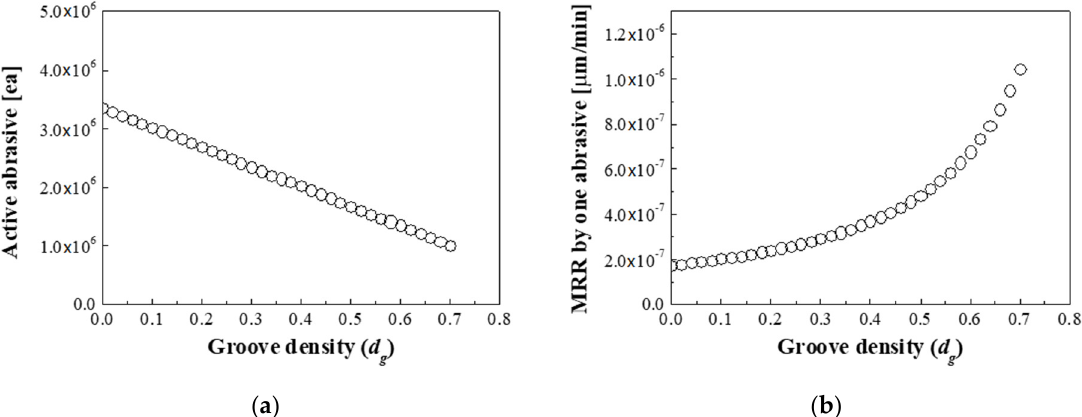
Figure 4. ( a ) Theoretical analysis result of number of active abrasives; ( b ) theoretical analysis result of material removal rate by one abrasive as a function of groove density.